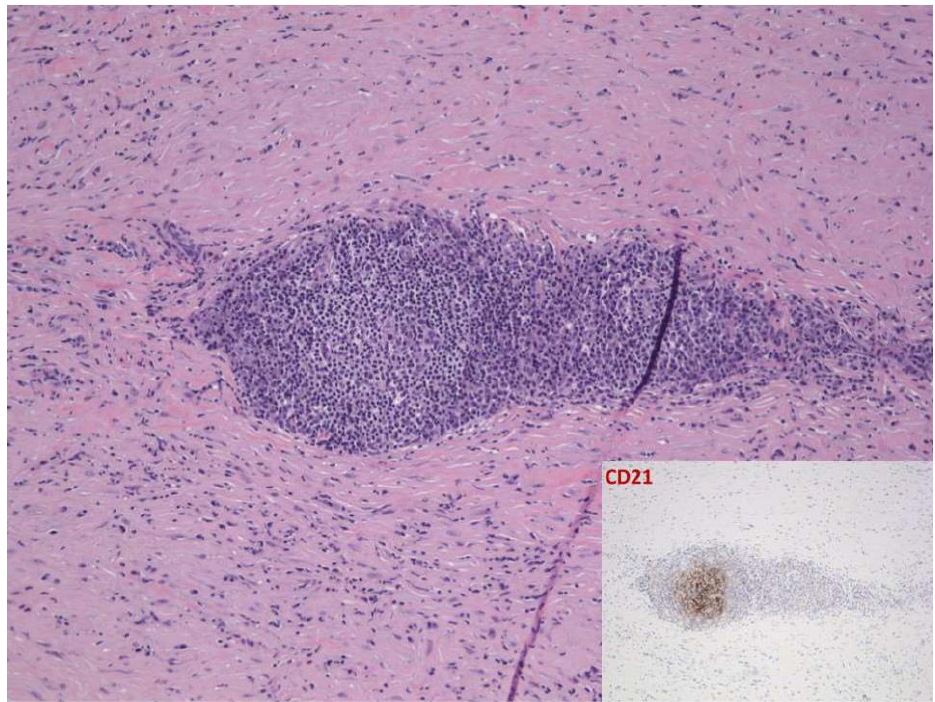
Figure 4. Case 2: Follicular architecture underlined by dendritic cell meshwork.